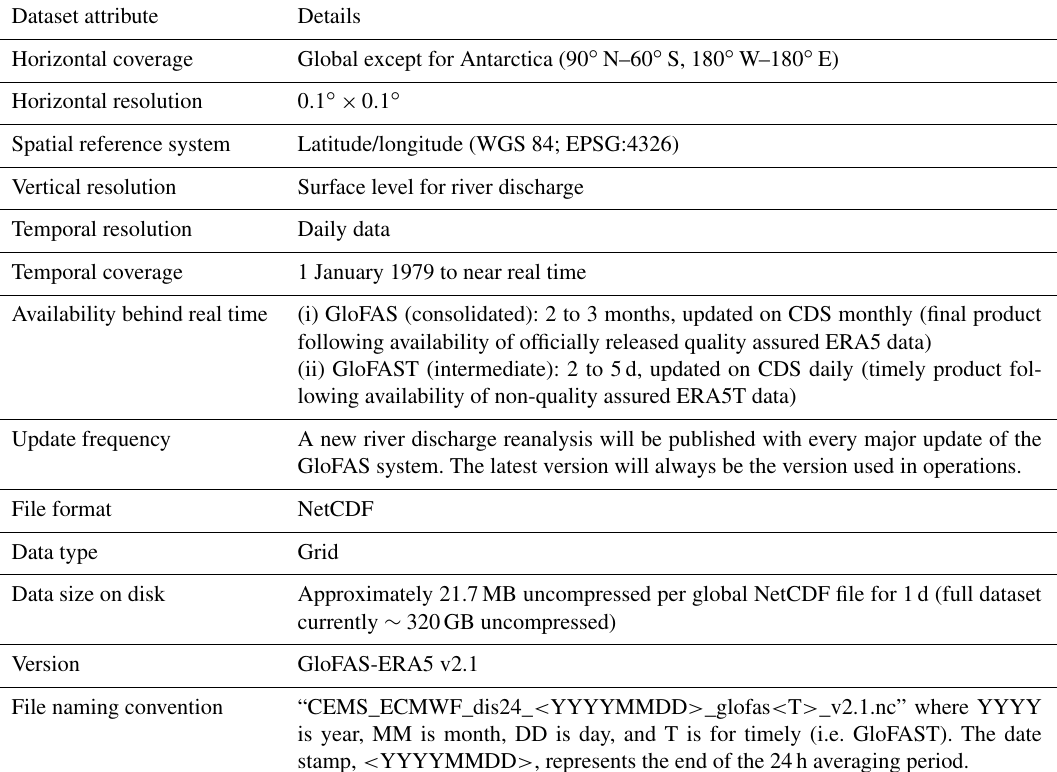
Table 2. Summary of GloFAS-ERA5 dataset attributes in the C3S Climate Data Store.